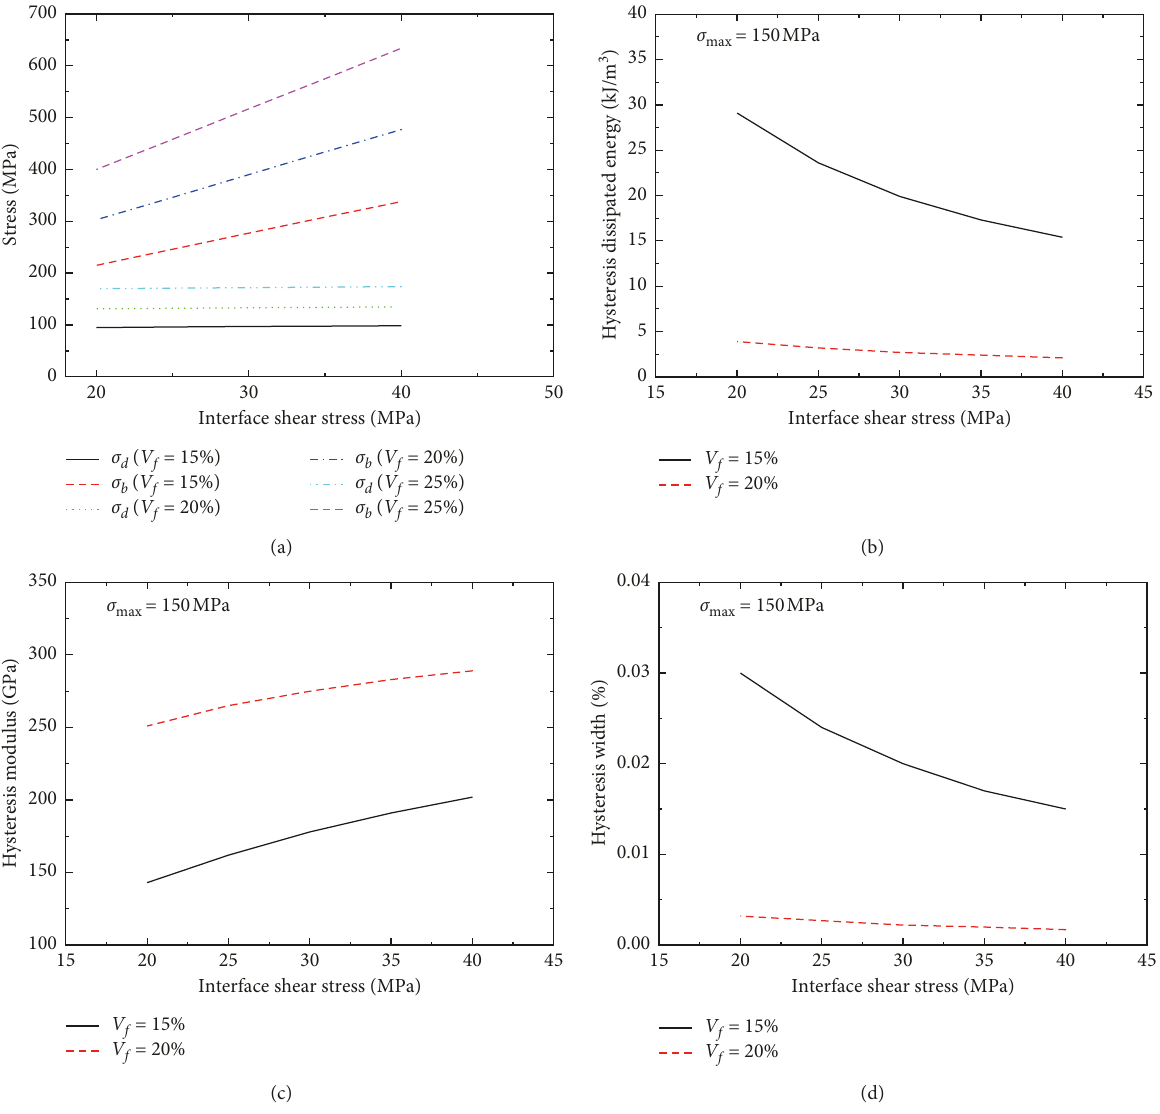
Figure 5: (a) The initial interface debonding stress and complete interface debonding stress versus the interface shear stress curves; (b) the fatigue hysteresis dissipated energy versus the interface shear stress curves; (c) the fatigue hysteresis modulus versus the interface shear stress curves; (d) the fatigue hysteresis width versus the interface shear stress curves for different fiber